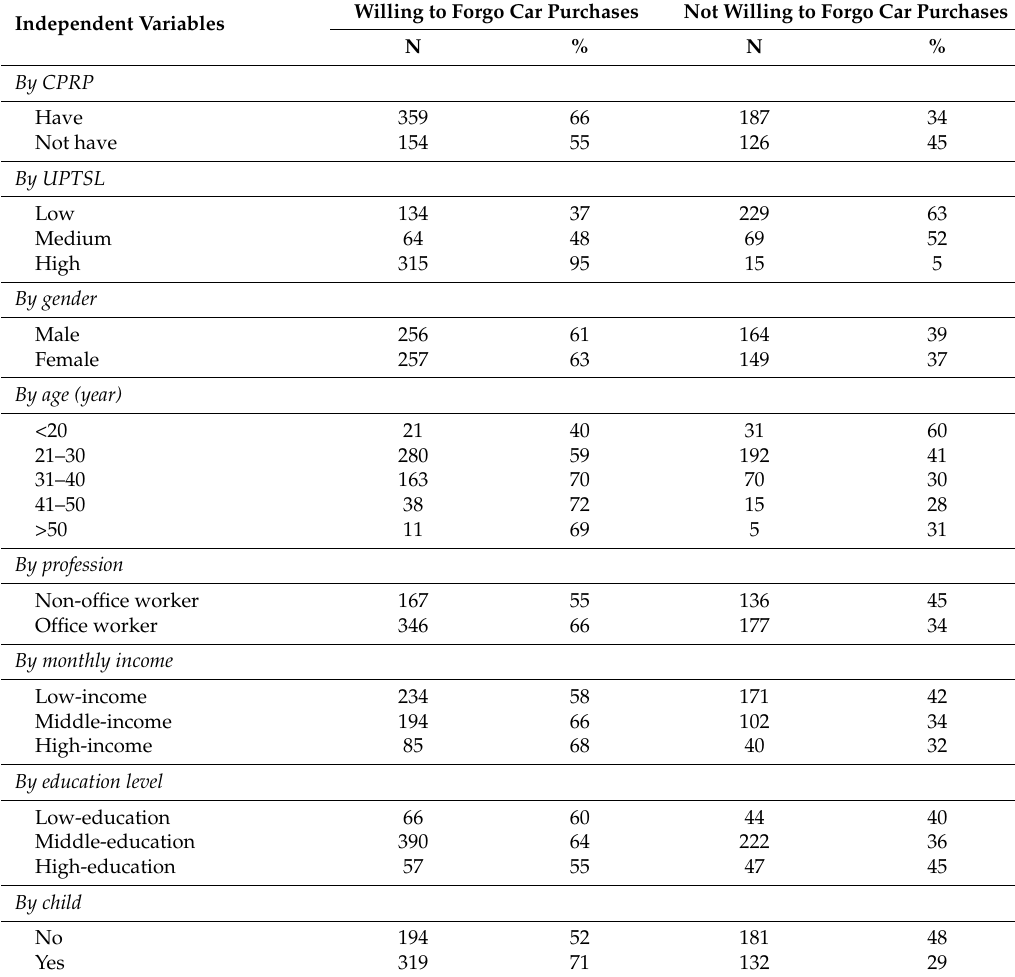
Table 4. Participants’ willingness to forgo car purchases based on different categories of independent variables. Independent